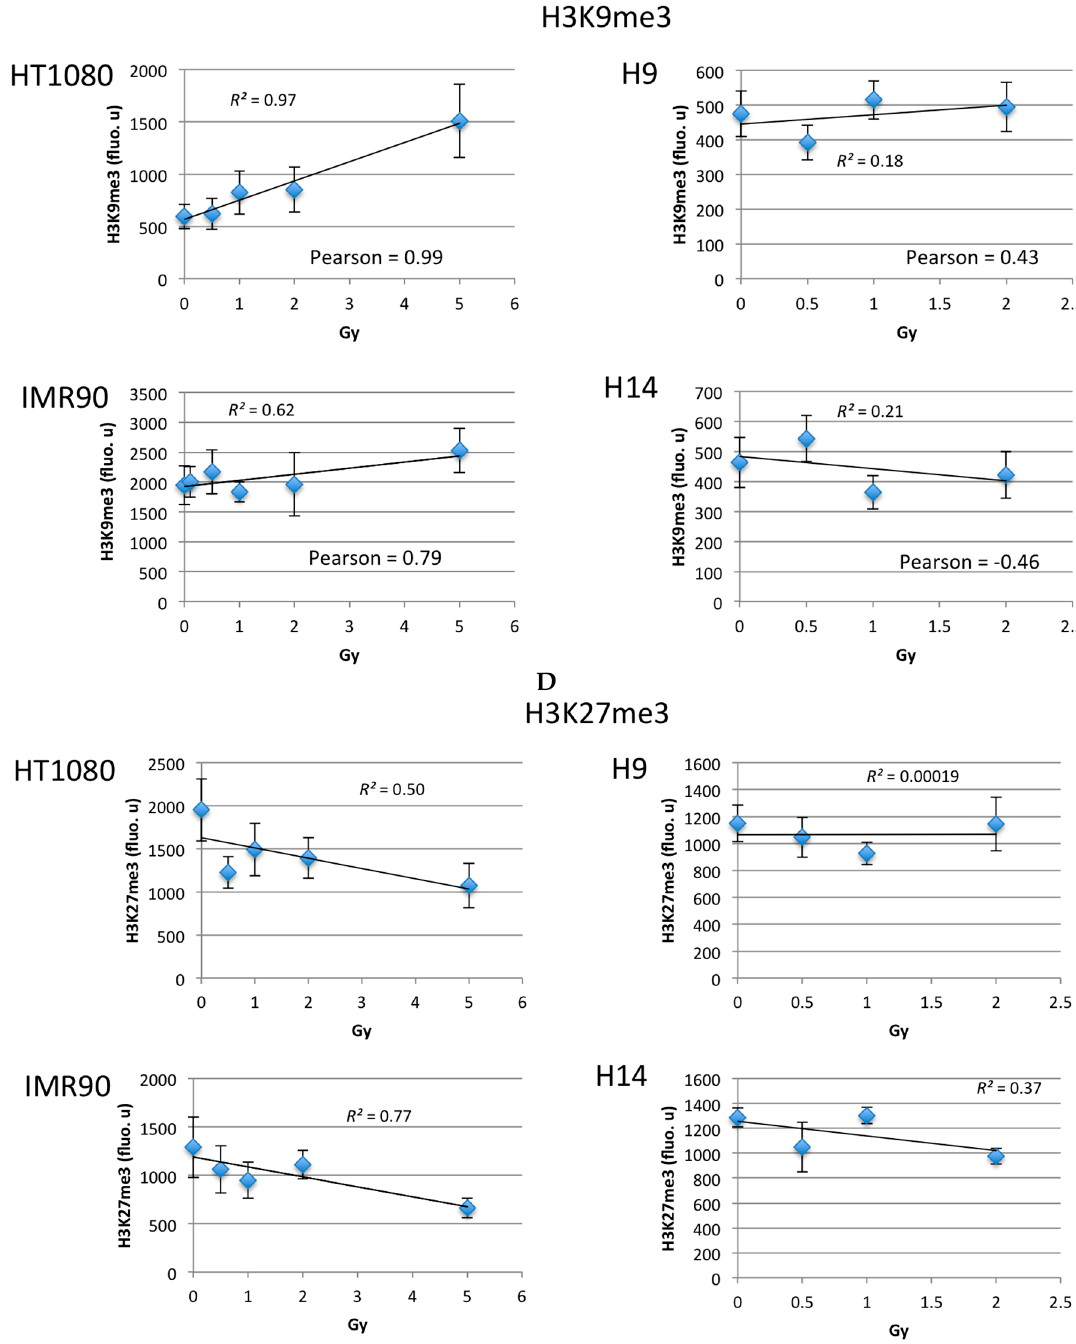
Figure 2. Immunofluorescent microscopy staining for H3K9me3 ( green , left panels) and H3K27me3 ( green , right panels), DAPI ( blue ) of ( A ) HT1080; ( B ) IMR90; ( C ) H9 hES cell lines exposed to various doses of IR; 0 Gy is the sham-exposed control. Intersecting regions of green and blue staining show as cyan on the merged images; scale bars are 10 µm. Dependence of staining intensity (arbitrary fluorescent units) for ( D ). H3K9me3 and ( E ) H3K27me3 from exposure dose (Gy) for various cell lines (indicated). The slopes of the best-fit linear regression line and Pearson’s correlation coefficients are shown on the graphs. HT1080 H3K9me3 expression: slope is significantly non zero ( p < 0.01); HT1080: H3K27me3 expression: slope is non zero (not significant, p = 0.13); IMR90 h3k9me3: p = 0.25; IMR90 h3k27me3: p = 0.05